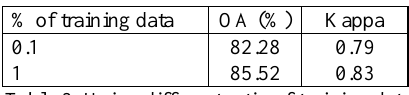
Table 3. Using different ratio of training